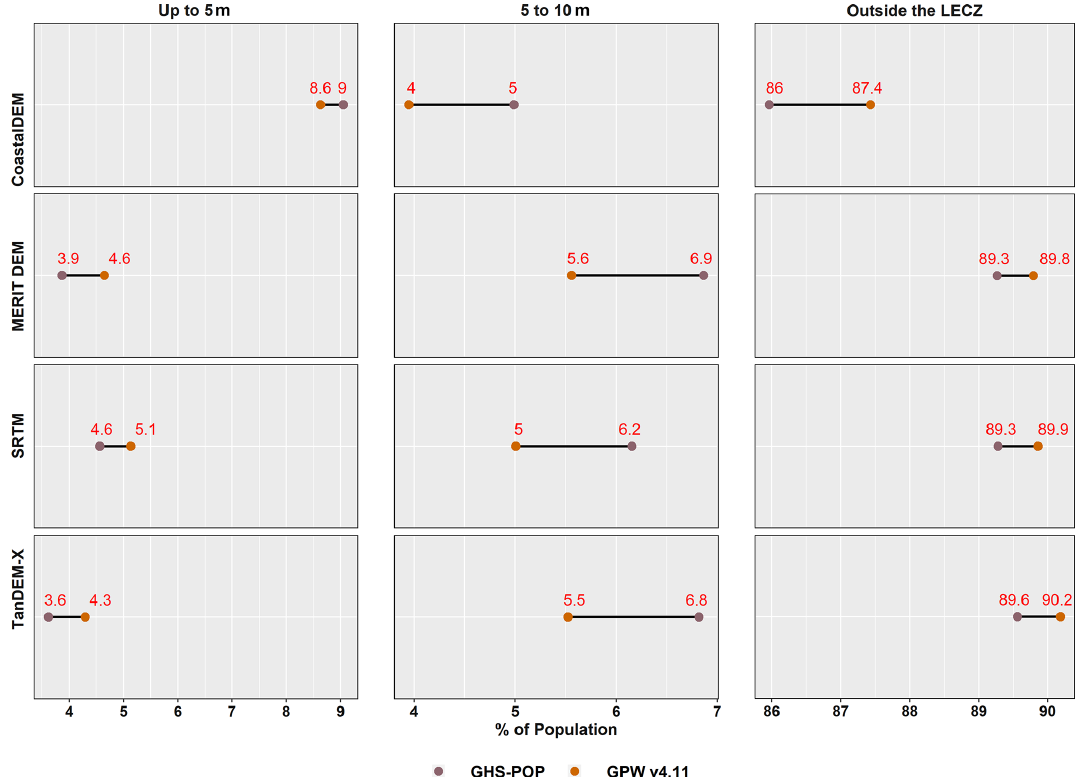
Figure B11. Estimates of population in different LECZs, by elevation and population data sources, 1990.